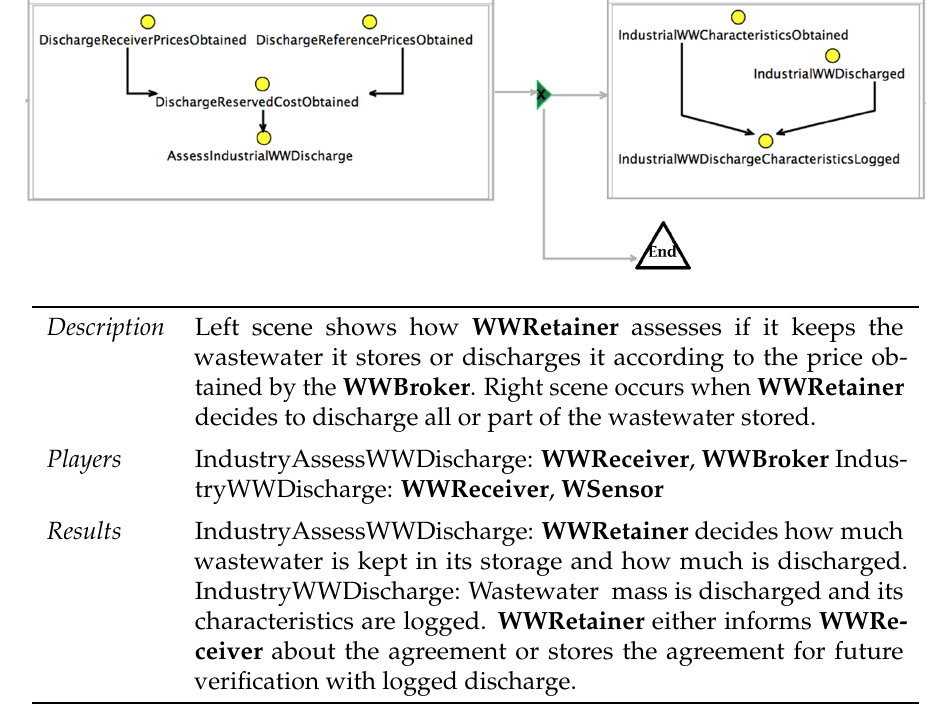
Figure A4. Landmark patterns for the industry discharge. It shows the decision process carried out by the Industry agent to manage its wastewater: keeping it stored or discharging it so a WWTP can process it. Such a decision depends on the processing price and the agent’s reserved cost.